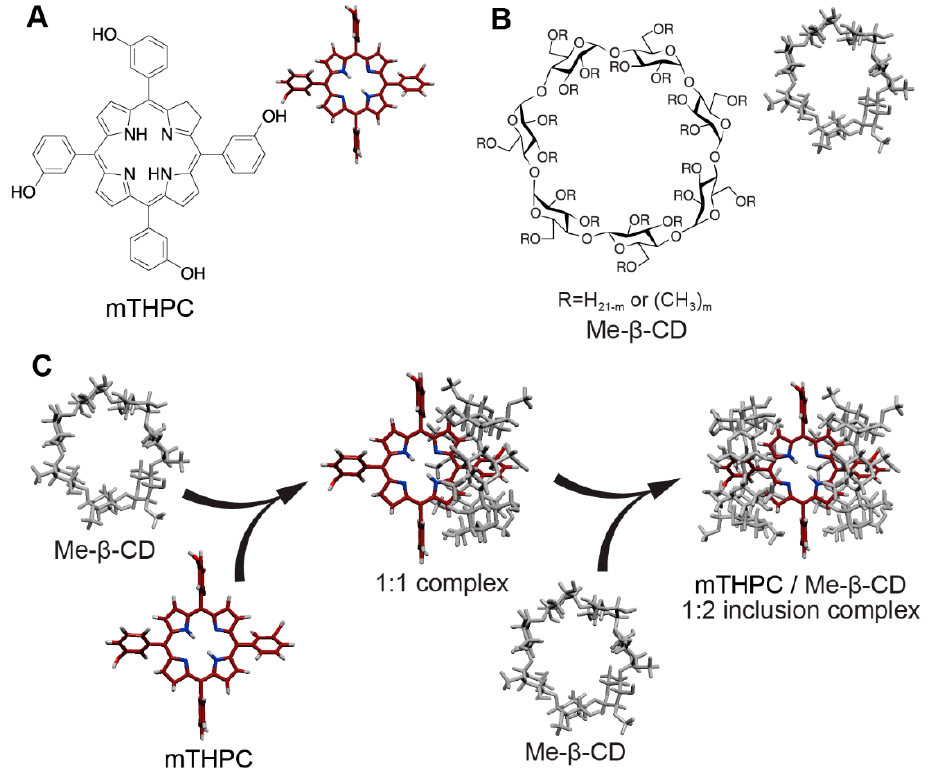
Figure 1. Molecular structures and 3D models of ( A ) mTHPC and ( B ) randomly methylated β - cyclodextrin (Me- β -CDs). The degree of substitution (m = 11–14), as reported in the experimental section. ( C ) The 3D schematic representation of the stepwise formation of 1:2 inclusion host − guest complex between mTHPC and two Me- β -CDs.